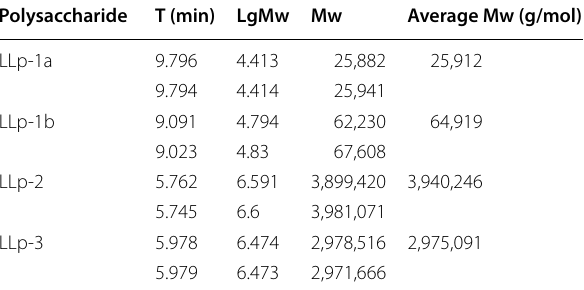
Table 1 Molecular weight of polysaccharides form Ligus- trum lucidum Ait flowers Polysaccharide